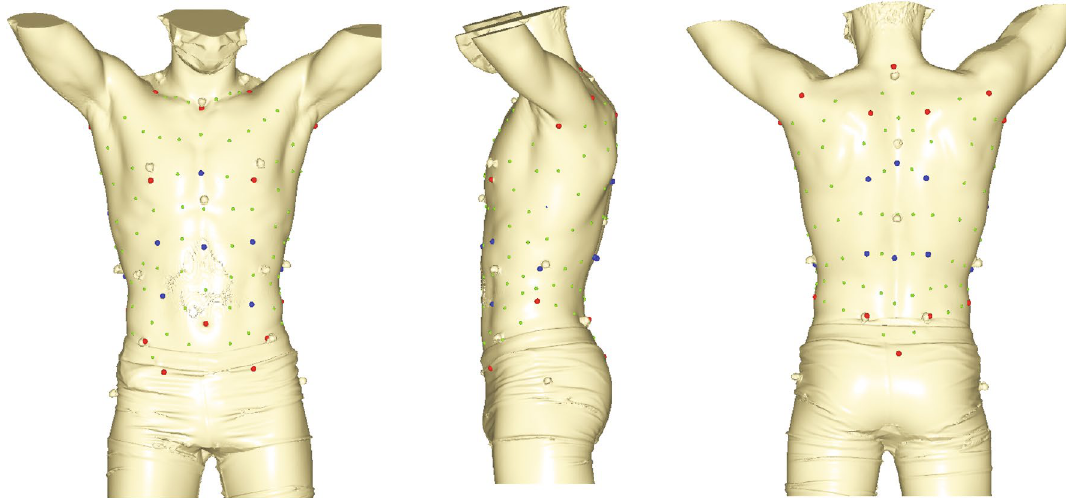
Figure 1. Frontal, lateral and posterior views of the 3D landmarks on the trunk surface. Red dots are fixed landmarks (Supplementary Table 1) and anatomically homologous between subjects, blue dots are curve semilandmarks, and green dots are surface semilandmarks. After resliding the semilandmarks are mathematically homologous among subjects.